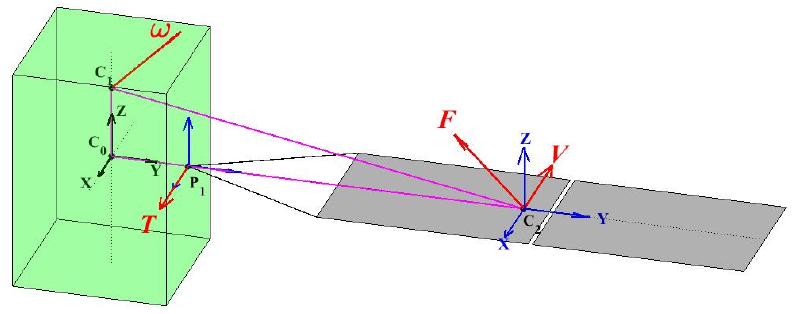
Figure 4. Schematic diagram of solar panel motion and root hinge stress analysis.